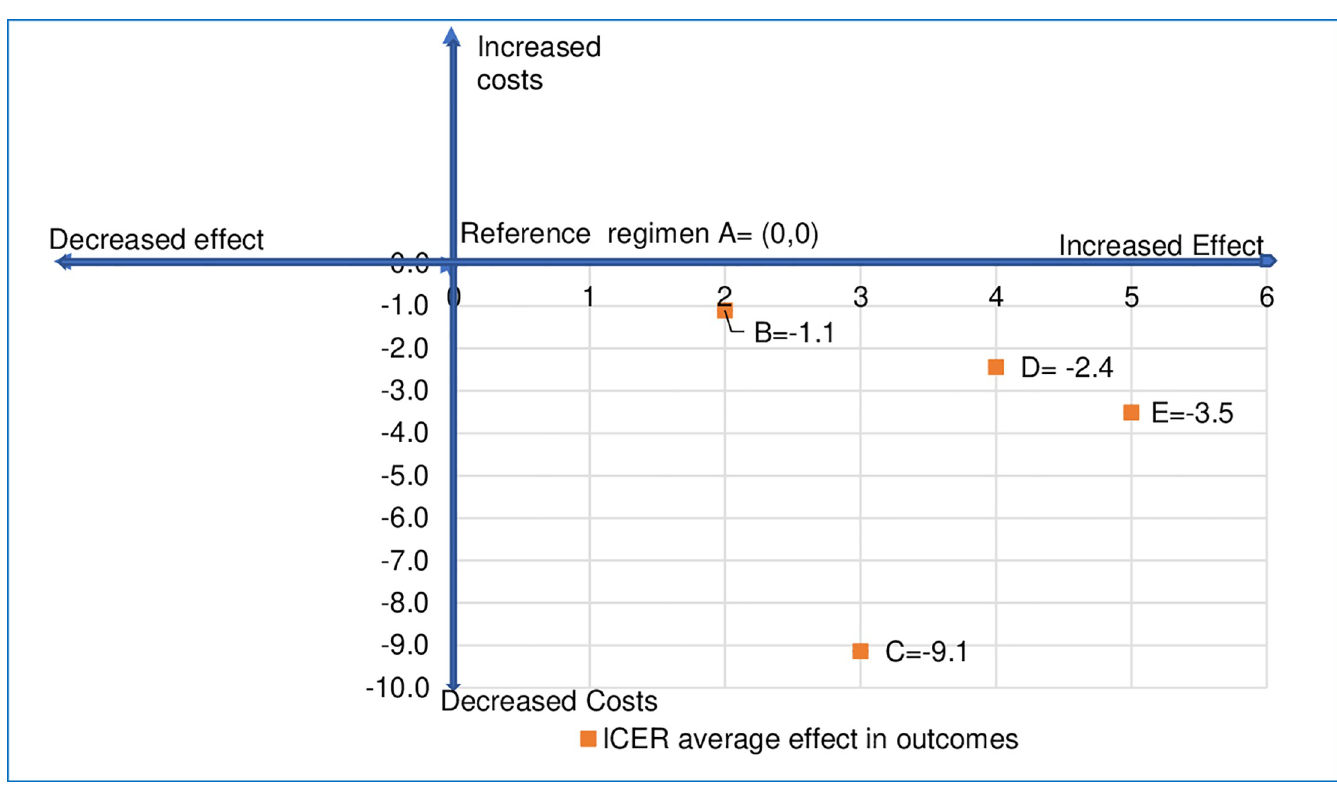
Fig 1. Incremental cost-effectiveness ratios (ICER) for treating young infants with clinical severe infection and fast breathing with different regimens for outcome/effect based on non-treatment failure on day 8 after enrollment.